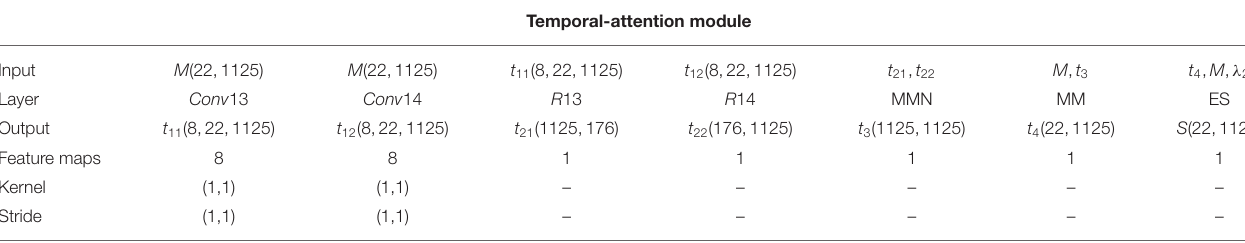
Temporal-attention module